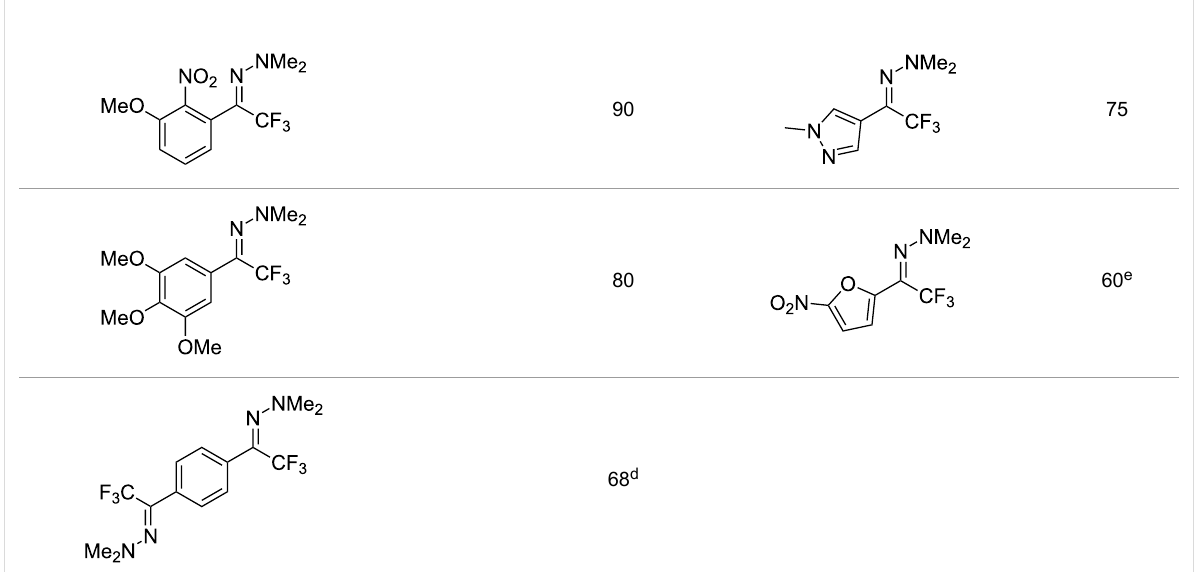
Table 18: Baudoin’s Cu-catalyzed trifluoromethylation of N , N -disubstituted (het)arylhydrazones [85]. (continued)